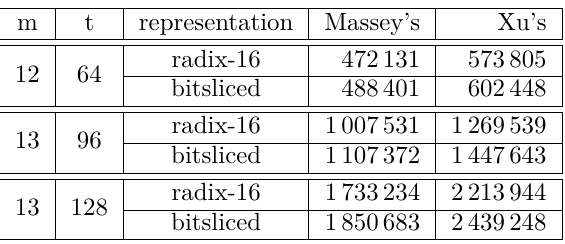
Table 8: Cycle counts of BM with different implementation choices. Note that the parameter sets mceliece348864* use ( m, t ) = (12 , 64); mceliece460896* use ( m, t ) = (13 , 96); mceliece6688128* and mceliece8192128* use ( m, t ) = (13 ,